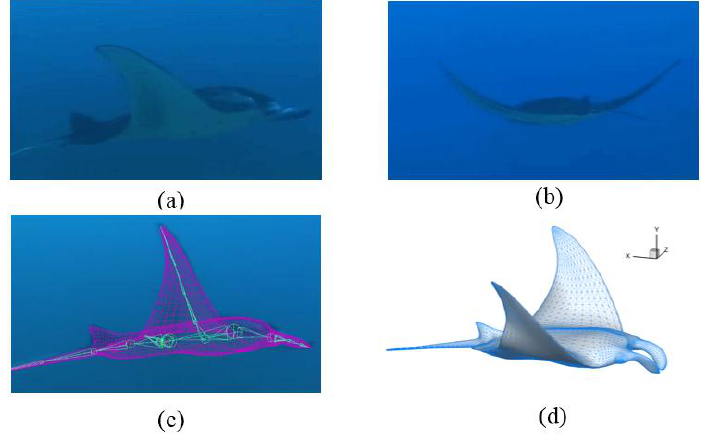
Figure 4. ( a ) Lateral view image of manta swimming; ( b ) rear view image of manta swimming; ( c ) virtual skeletons and the manta model; ( d ) the reconstructed model.